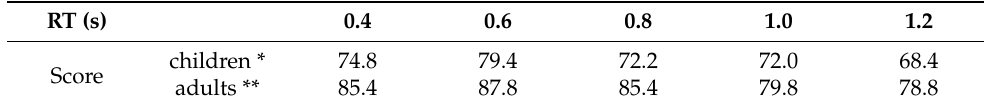
Table 11. The results of speech intelligibility testing (average scores).